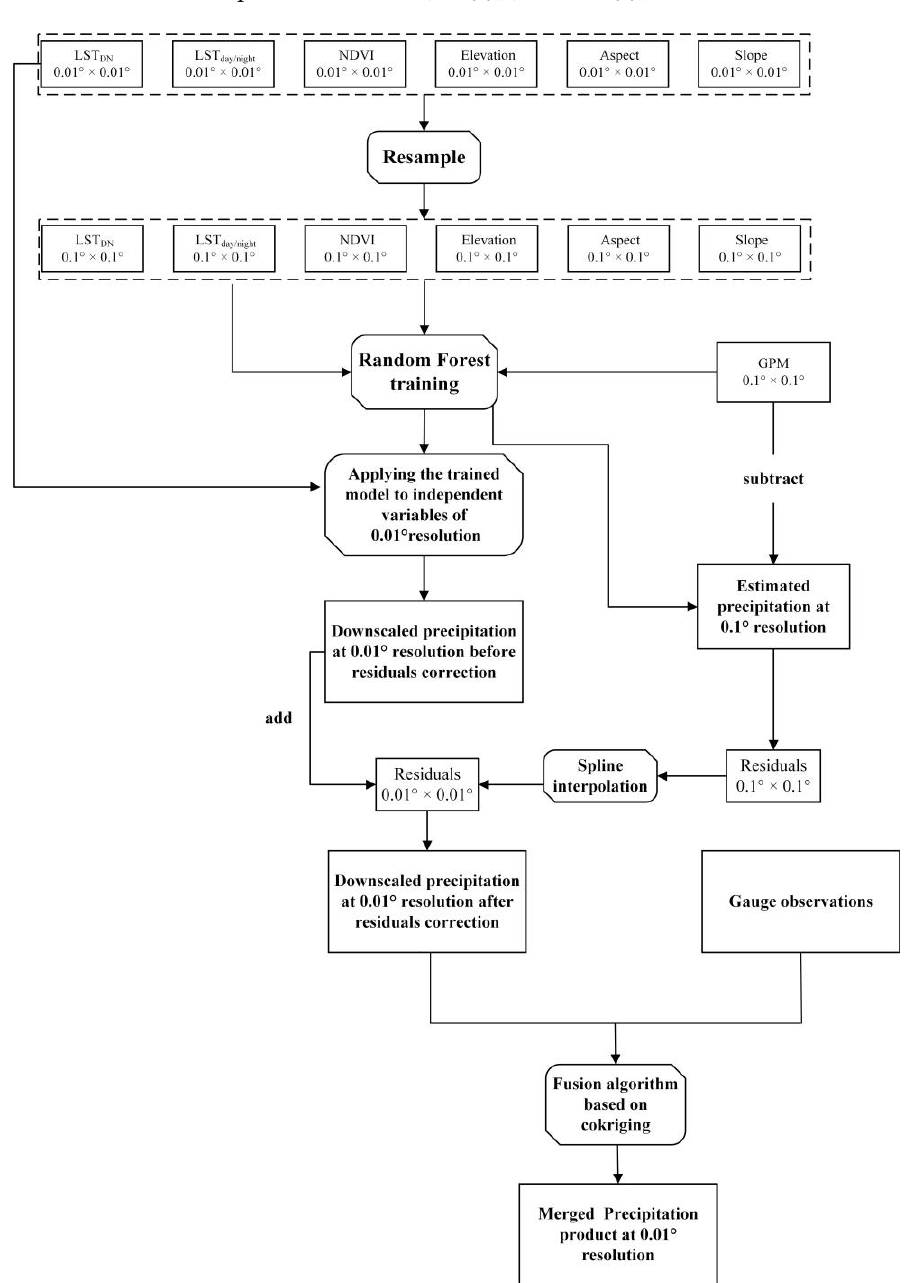
Figure 3. Flowchart of the two-step downscaling – merging scheme based on RF and cokriging. After the above steps, the high-resolution seasonal precipitation estimation (Seasonal GPM 0.01 ◦ ) can be